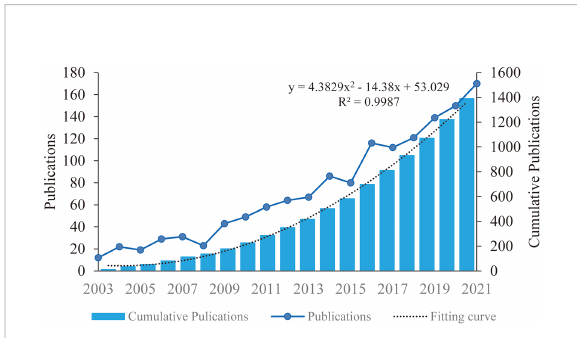
FIGURE 2 Publication growth trend of TNF in PSN publications from 2003 to 2021.